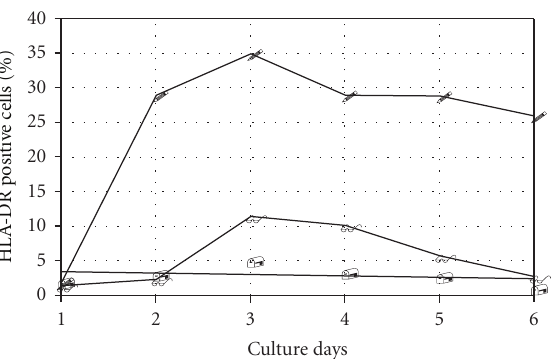
Figure 1: Time-dependent e ff ect of sodium selenite (100nM/mL) on IFN- γ (100 U/mL) induced HLA-DR expression. (i) Dots: HLA- DR expression without sodium selenite. (ii) Square: HLA-DR expression with sodium selenite (100 nM/mL). (iii) Filled square: HLA-DR expression with sodium selenite.